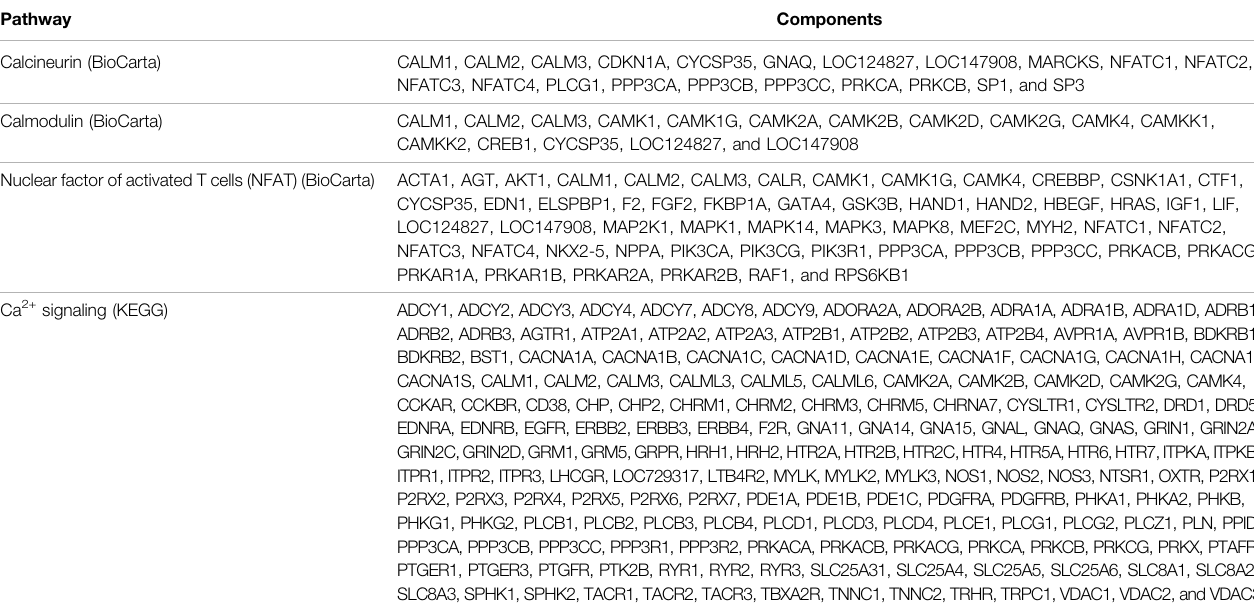
TABLE 2 | BioCarta and KEGG pathways. Components of the calcineurin, calmodulin, NFAT, and Ca 2+ signaling pathways are listed. Pathway